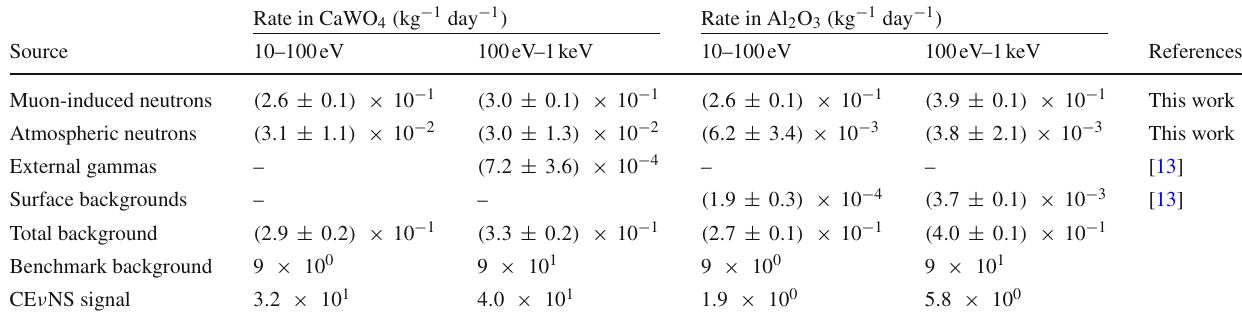
detector array. For the muon veto an efficiency of 99% is assumed. The background rate from external γ -rays has been determined only for CaWO 4 crystals in the ROI, while for surface events the MC simula- tions were performed with a Al 2 O 3 NUCLEUS array. The benchmark background is the background count rate used in the sensitivity studies presented in Sect. 6. The CE ν NS signal count rate is calculated for the nominal reactor power. See text for